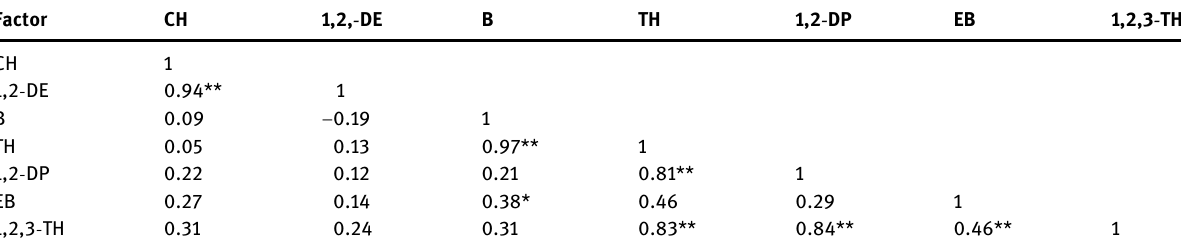
Table 4: Correlation coe ffi cient matrix of the VOCs in chemical site soils Factor